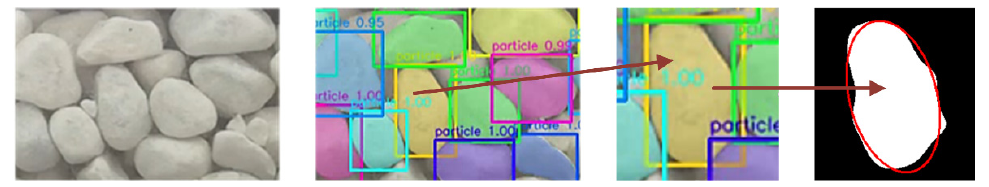
Figure 5. Equivalent ellipse characterization method.